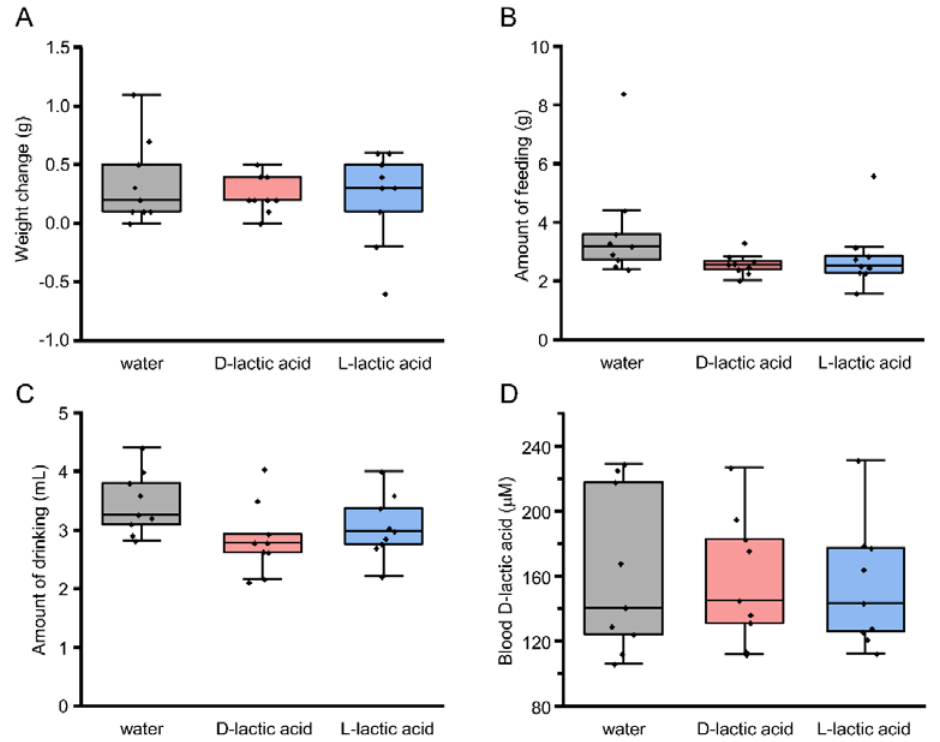
Figure 6. Blood D -lactic acid levels after ingestion of L - or D -lactic acid. ( A – C ) Weight change of mice ( A ), total food intake ( B ), and total solution intake ( C ) during 12 h presentation of food and solution (water, 30 mM L -lactic acid, or 30 mM D -lactic acid) ( n = 9). ( D ) Blood D -lactic acid levels after 12 h presentation of food and solution (water, 30 mM L-lactic acid, or 30 mM D -lactic acid) ( n = 9). In these box plots, the box indicates the 25th and 75th percentiles; the line across the box, the median; and whiskers, maximum and minimum values. Each point indicates individual data. Table 1. Two-way ANOVA results for short-term lick test.